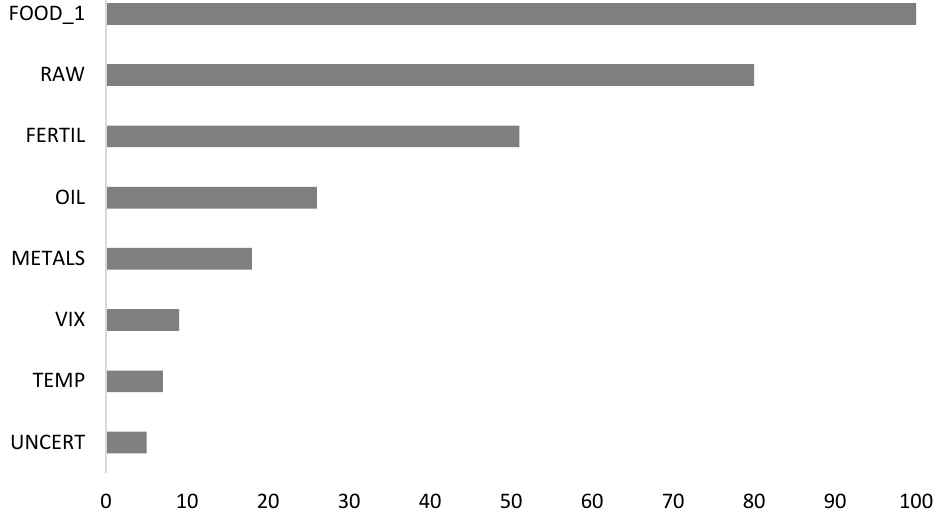
Figure 3. Variable importance analysis.